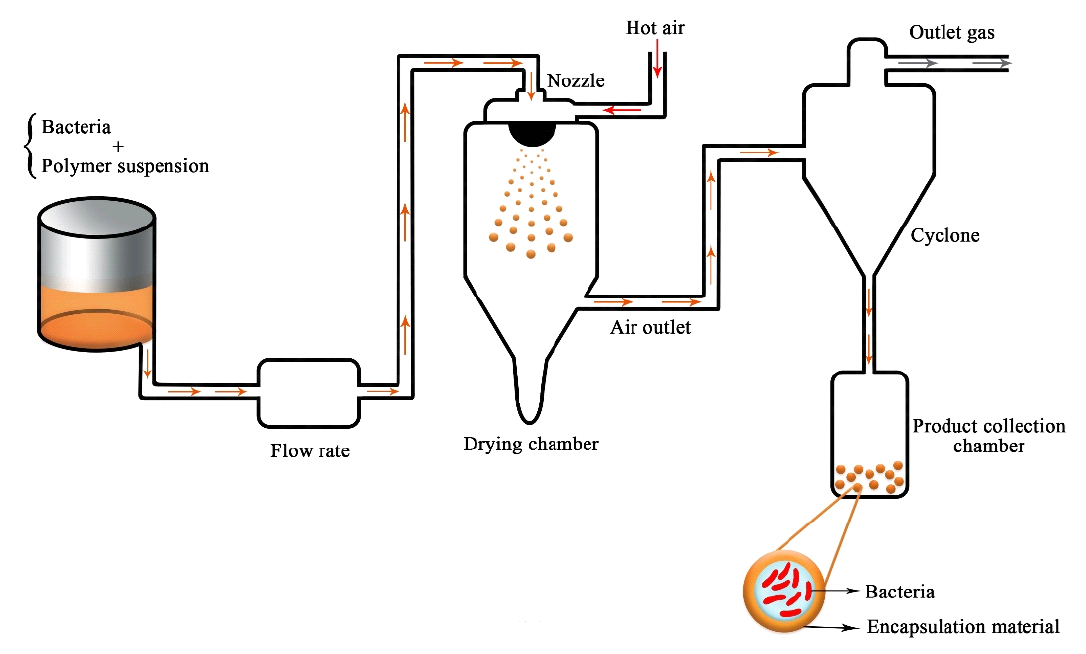
Figure 4. Schematic depiction of the spray-drying technique for bacteria encapsulation (adapted from [96]).